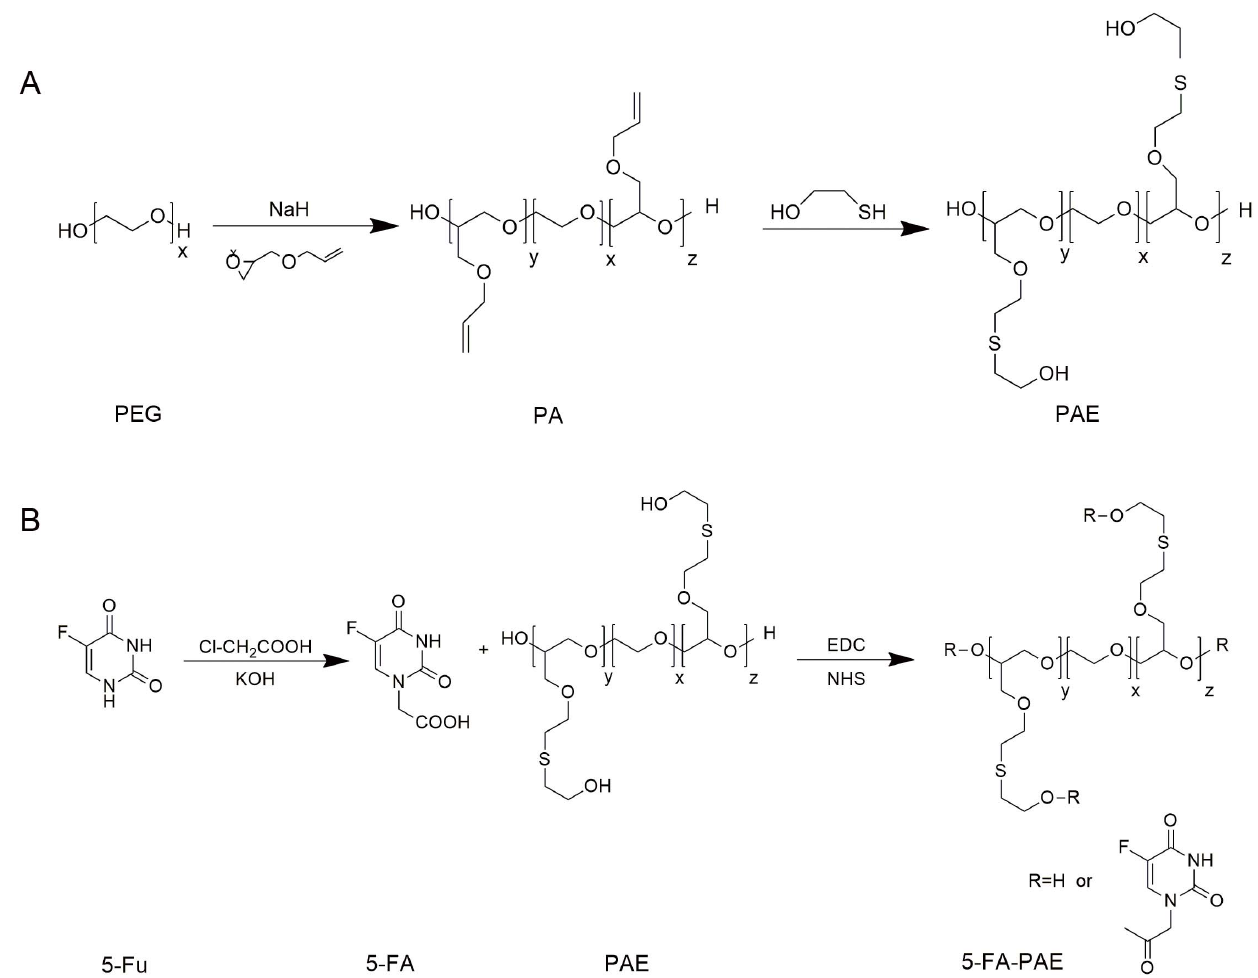
Figure 1. Synthesis routes of PAE (A) and 5-FA-PAE conjugates (B). (A) PA was synthesized by adding NaH to PEG and the mixture was stirred for 4 h at 120 u C. Then PAE was obtained by adding AGE to the mixture. (B) 5-FA was added dropwise to PAE in dimethylformamide, then NHS and EDC ? HCl were added. After incubation, the mixture was precipitated with isopropanol. The obtained residue was recrystallized by isopropanol several times and dried in vacuum at 40 u C overnight to produce 5-FA-PAE.